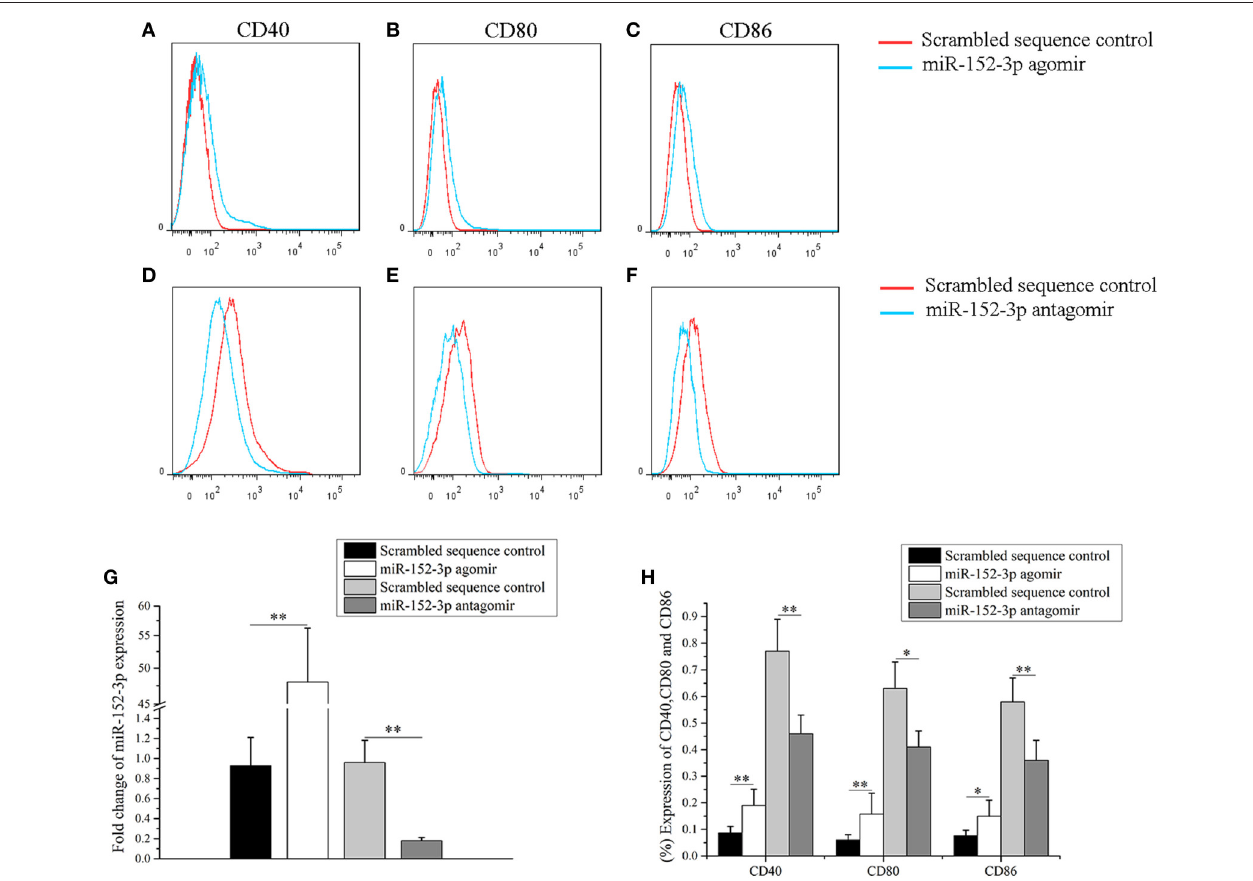
FIGURE 2 | miR-152-3p promoted B-cell responsiveness. (A–C) Upregulation of miR-152-3p expression in the B-cells of healthy controls increased CD40, CD80, and CD86 expression levels. Transfected cells were stained with PE-Cy7-conjugated anti-human CD40, FITC-conjugated anti-human CD80, and PerCP-Cy5.5-conjugated anti-human CD86, and then were analyzed by using flow cytometry. (D–F) Downregulation of miR-152-3p expression in the B-cells of patients with SLE decreased the expression levels of CD40, CD80, and CD86. Transfected cells were stained with PE-Cy7-conjugated anti-human CD40, FITC-conjugated anti-human CD80, and PerCP-Cy5.5-conjugated anti-human CD86, and analyzed using flow cytometry. (G) The expression of miRNA-152-3p in different transfection groups. (H) Statistical analysis of percentage of CD40, CD80, and CD86 in different transfection groups. All experiments were performed in triplicate. The variables were compared using the paired t -test. * P < 0.05 and ** P < 0.01.